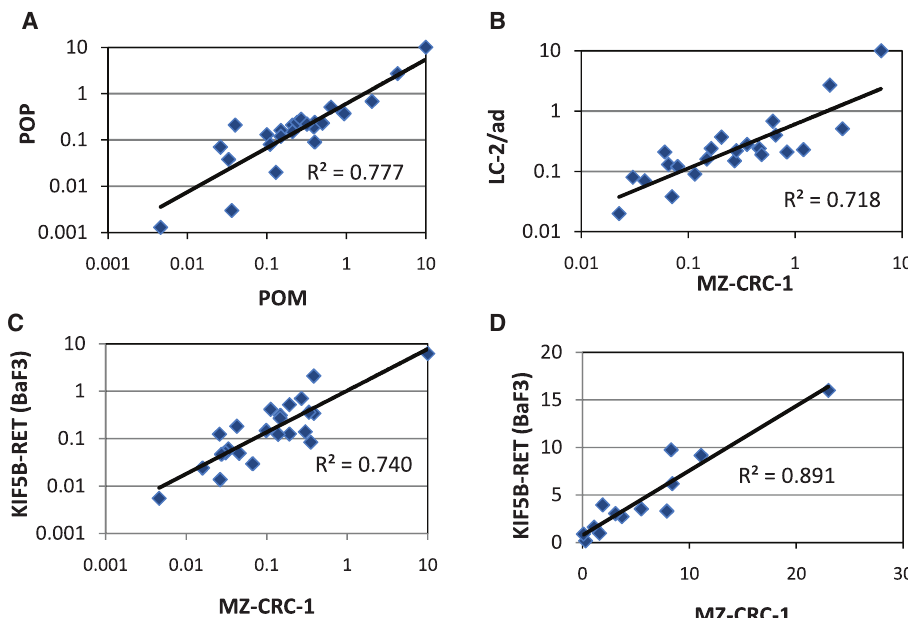
data in MZ-CRC-1 and LC-2/ad C ) POM 50